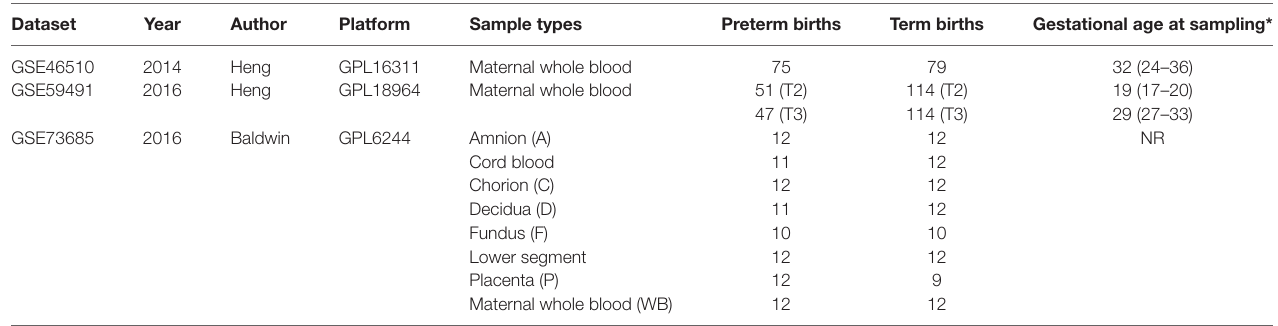
taBle 1 | Datasets used in discovery